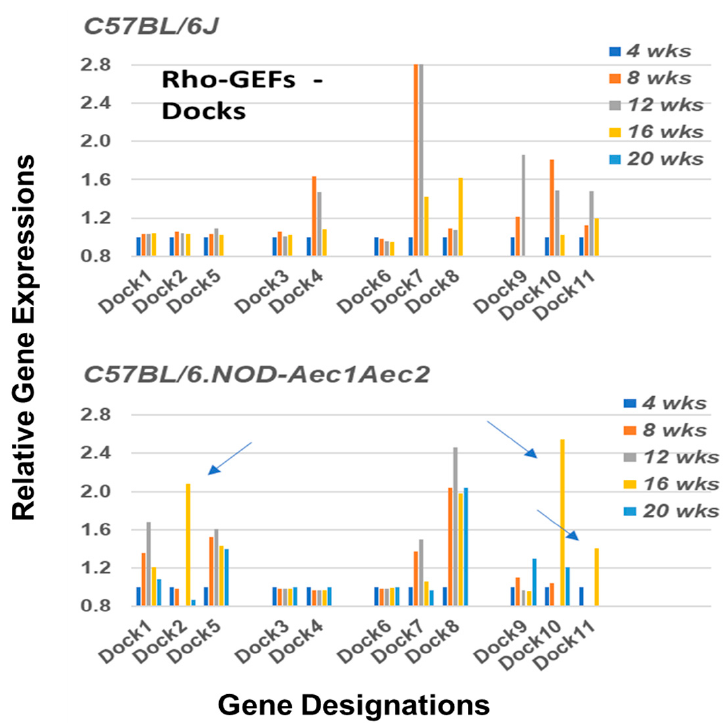
Figure 5. Upregulated profiles of genes encoding for members of the Rho-GTPase Dock family of proteins. Transcriptome data showing the temporal expressions of the Dock genes upregulated in the salivary glands of C57BL/6.NOD- Aec1Aec2 mice ( lower panel ) versus C57BL/6J mice ( upper panel ). In the SS-susceptible C57BL/6.NOD- Aec1Aec2 mice three genes, Dock2 , Dock10 , and Dock11 , reported to be uniquely associated with B and T lymphocyte functions, exhibit a concomitant upregulated short-term expression at 16 weeks of age (arrows), while Dock1 , 5 , 7 and 8 are each upregulated starting at 4 weeks of age and remain activated out to 16 or 20 weeks of age. In contrast, in the SS-non-susceptible C57BL/6J mice, Dock4 , 7 , 9 , 10 and 11 exhibit an upregulated expression starting at 4 weeks of age, while Dock8 shows a unique expression pattern being upregulated at 16 weeks of